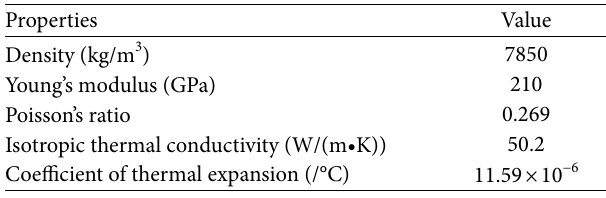
Table 3: Properties of rotor material.